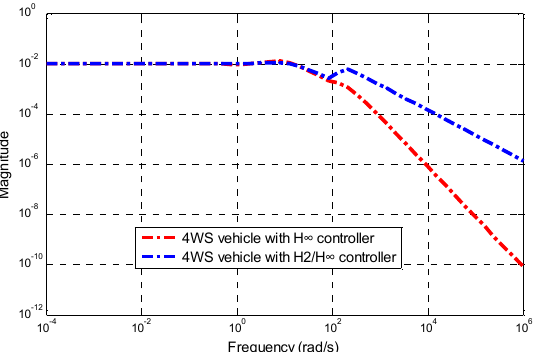
Figure 19. The frequency response of the maximum singular value of perturbation block 𝛥 transfer function matrix.